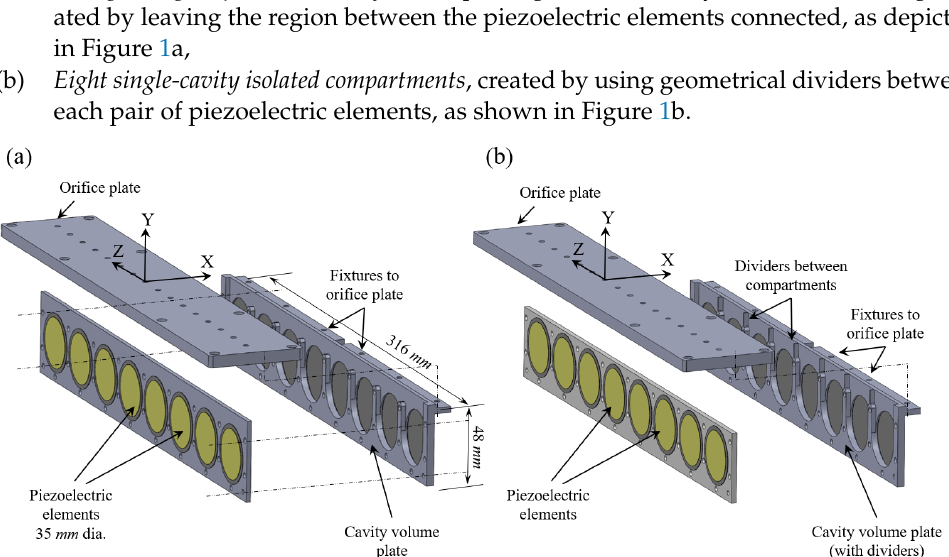
Figure 1. Exploded view of the SJA showing ( a ) the single cavity case, with 16 piezoelectric elements and 16 orifices, and ( b ) 8 single ‐ compartmented cavities, where the cavity volume plate illustrates how the division of the array cavity into 8 equal compartments is achieved. Dashed lines show the assembly lines.